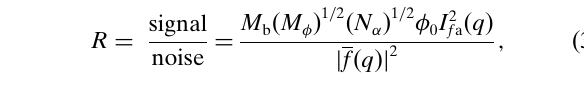
and I for nickel. The lines y ¼ bN f 0